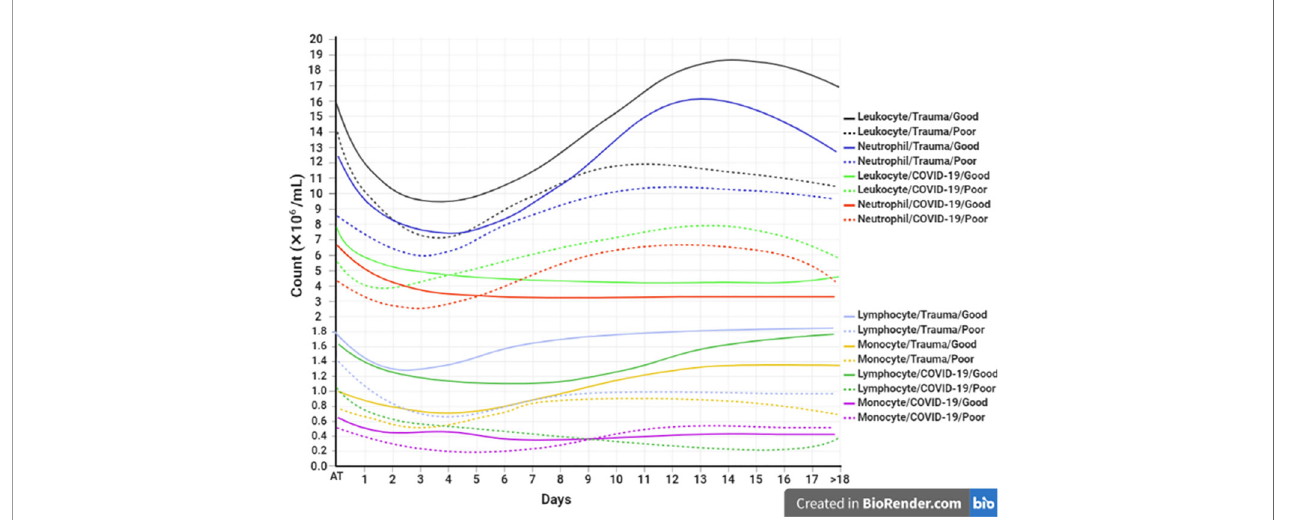
FIGURE 3 | Association between the kinetics of changes in blood cell count with prognosis in patients with COVID-19 and trauma. The timeline plot represents the kinetics of changes in leukocyte (30, 166, 167), neutrophil (30, 168), lymphocyte (30, 45, 167, 169, 170), and monocyte (30, 166, 171) counts during 18 days after admission in COVID-19 and trauma patients associated with good (solid lines) and poor (dashed lines) prognoses. COVID-19 patients with an increased risk of mortality, MOF, severe-to-critical forms of the disease, intensive care unit admission, and/or hospitalization are de fi ned as a poor prognosis for the disease. Conversely, patients with the opposite are de fi ned as having a good prognosis for the COVID-19. MOF, multiple organ